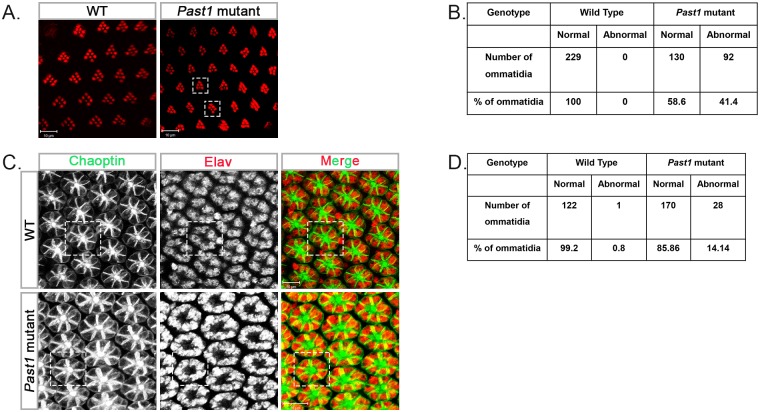
Ommatidial defects in Past1 mutant flies.(A) Phalloidin staining of wild type or Past1110-1 homozygous mutant late pupa eyes. Dotted squares mark ommatidia with less than seven rhabdomeres. (B) Quantification of abnormal ommatidia (with less than seven rhabdomeres) in late pupal eyes of wild type (n = 229) and of Past1110-1 mutants (n = 222) ommatidia; P < 0.001. (C) Elav (red) and chapotin (green) staining of wild type and Past1110-1mutant early-mid pupa eyes (42-48h after puparium formation). The dotted square outlines an ommatidium with eight normal photoreceptors in wild type and an ommatidium with abnormal seven photoreceptors in Past1110-1mutant eyes. (D) Quantification of abnormal number of photoreceptors in early-mid pupa eyes of wild type (n = 198) and of Past1110-1 mutant (n = 123) ommatidia; P < 0.001.